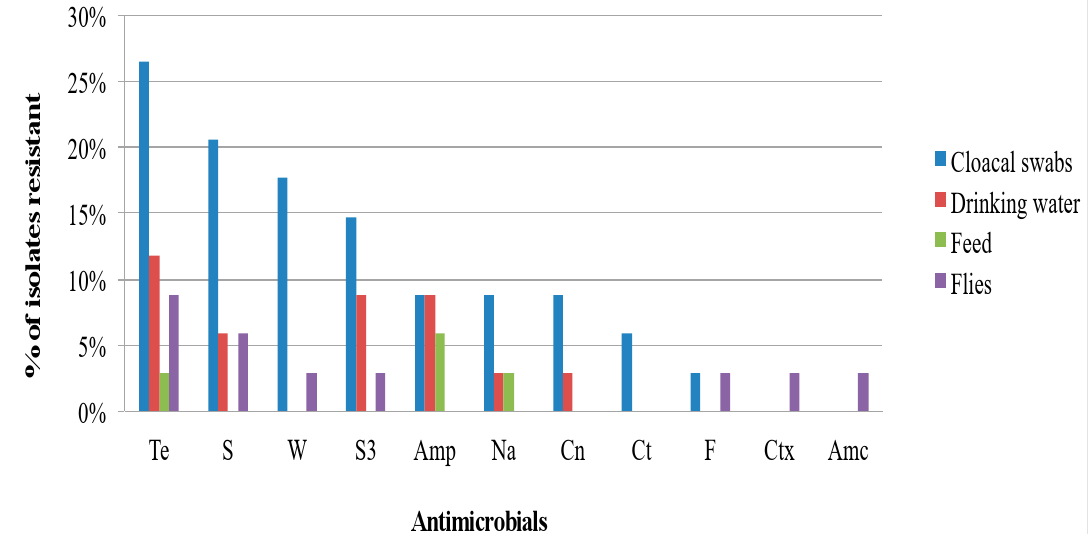
Figure 1. Frequency of Salmonella isolates recovered from various sources resistant to commonly used antibiotics from the South-central Peninsular Malaysia. (Te, Tetracycline; S, Streptomycin; W, Trimethoprim; S3, Sulfonamides; Amp, Ampicillin; Na, Nalidixic acid; Cn, Gentamicin; Ct, Chloramphenicol; F, Nitrofurantoin; Ctx, Cefotaxime; Amc, Amoxicillin-clavulanate). Antibiotics 2020 , 9 , x FOR PEER REVIEW